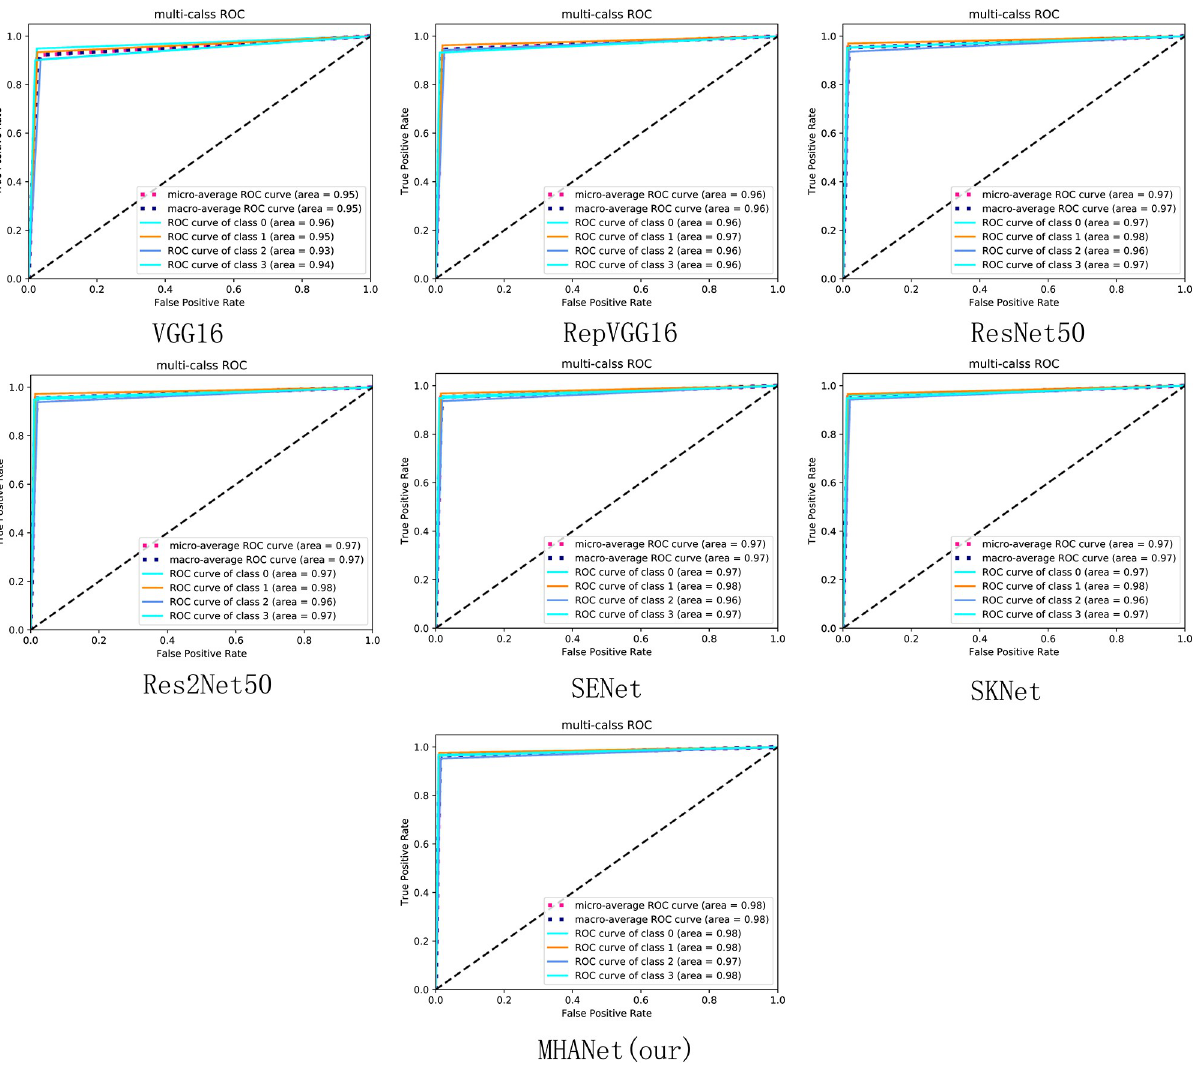
Fig 10. The micro-average ROC curve is obtained by the micro method in the sklearn.metrics.roc-auc-score function. The macro-average ROC curve is obtained by the macro method in the sklearn.metrics.roc-auc-score function. Class 0, class 1, and class 2 in the figure represent CNV, DURSEN, DME, and NORMAL,